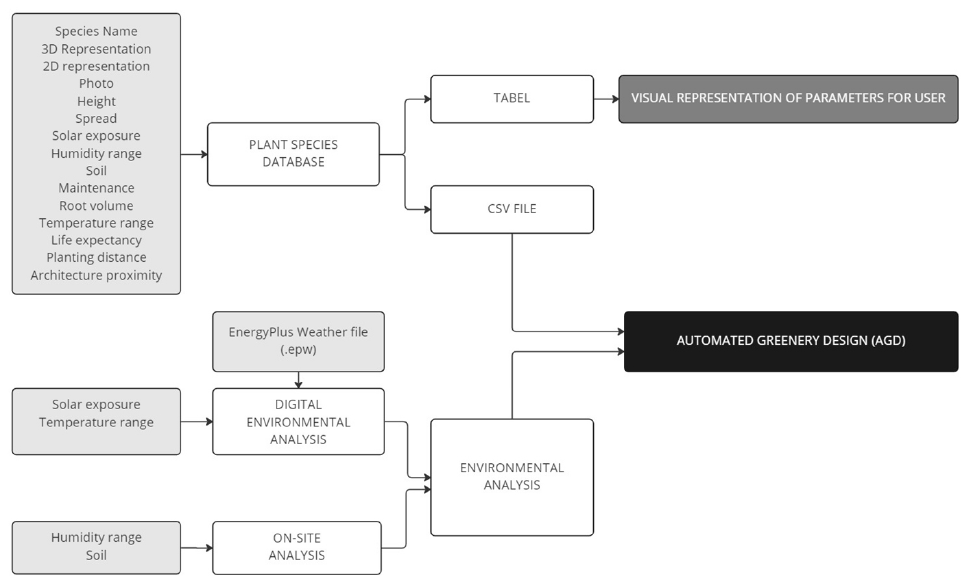
Figure 4. Automated greenery design (AGD) approach.